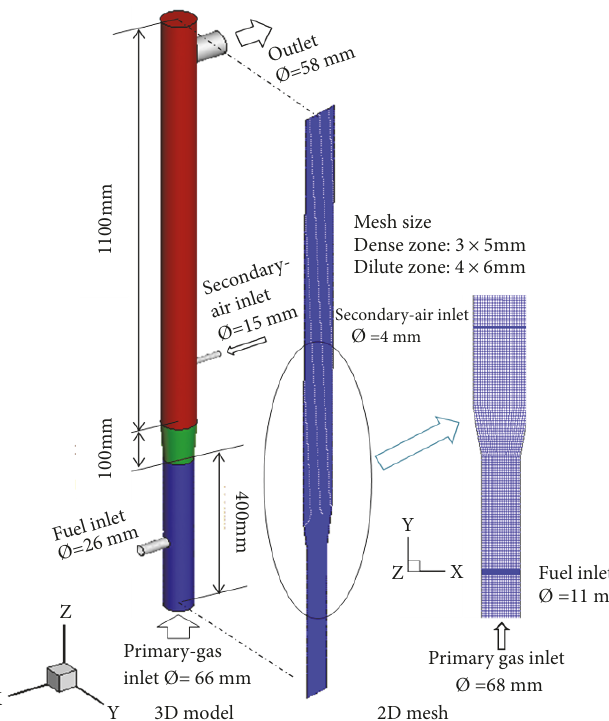
Figure 1: Schematics of the combustor and simulation grids.